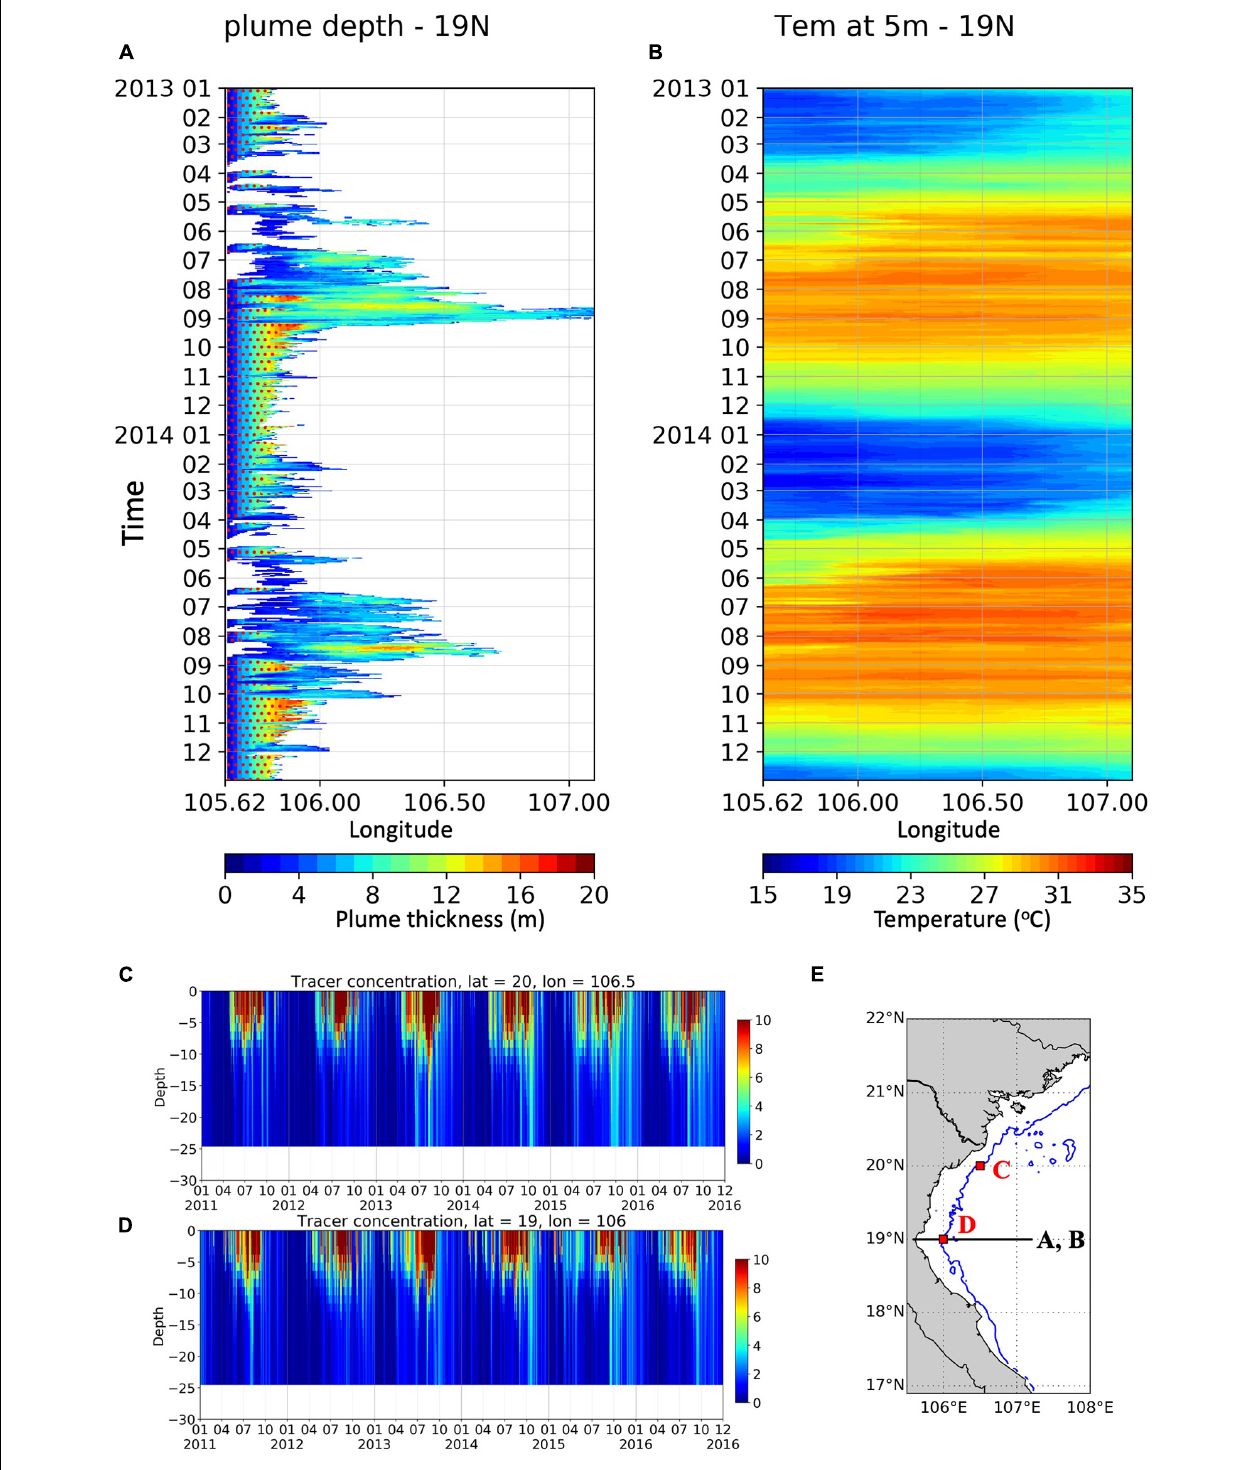
FIGURE 11 | (A) Plume thickness (m) at 19 ◦ N section from 2013 to 2014. Red points indicate the area where the plume is present over the whole depth. (B) Temperature ( ◦ C) at 5 m at the same section as (A) . (C,D) Tracer concentration over time at two coastal points. The location of the section and the points are shown in panel (E)